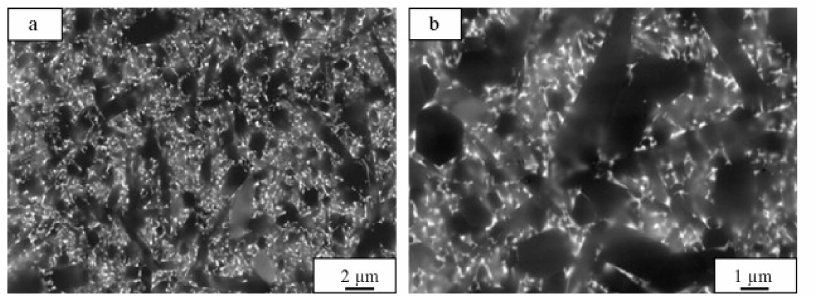
Figure 3. Back-scattered SEM images of as-sintered α / β -SiAlON composite ( a ) 10,000 × and ( b ) 20,000 ×